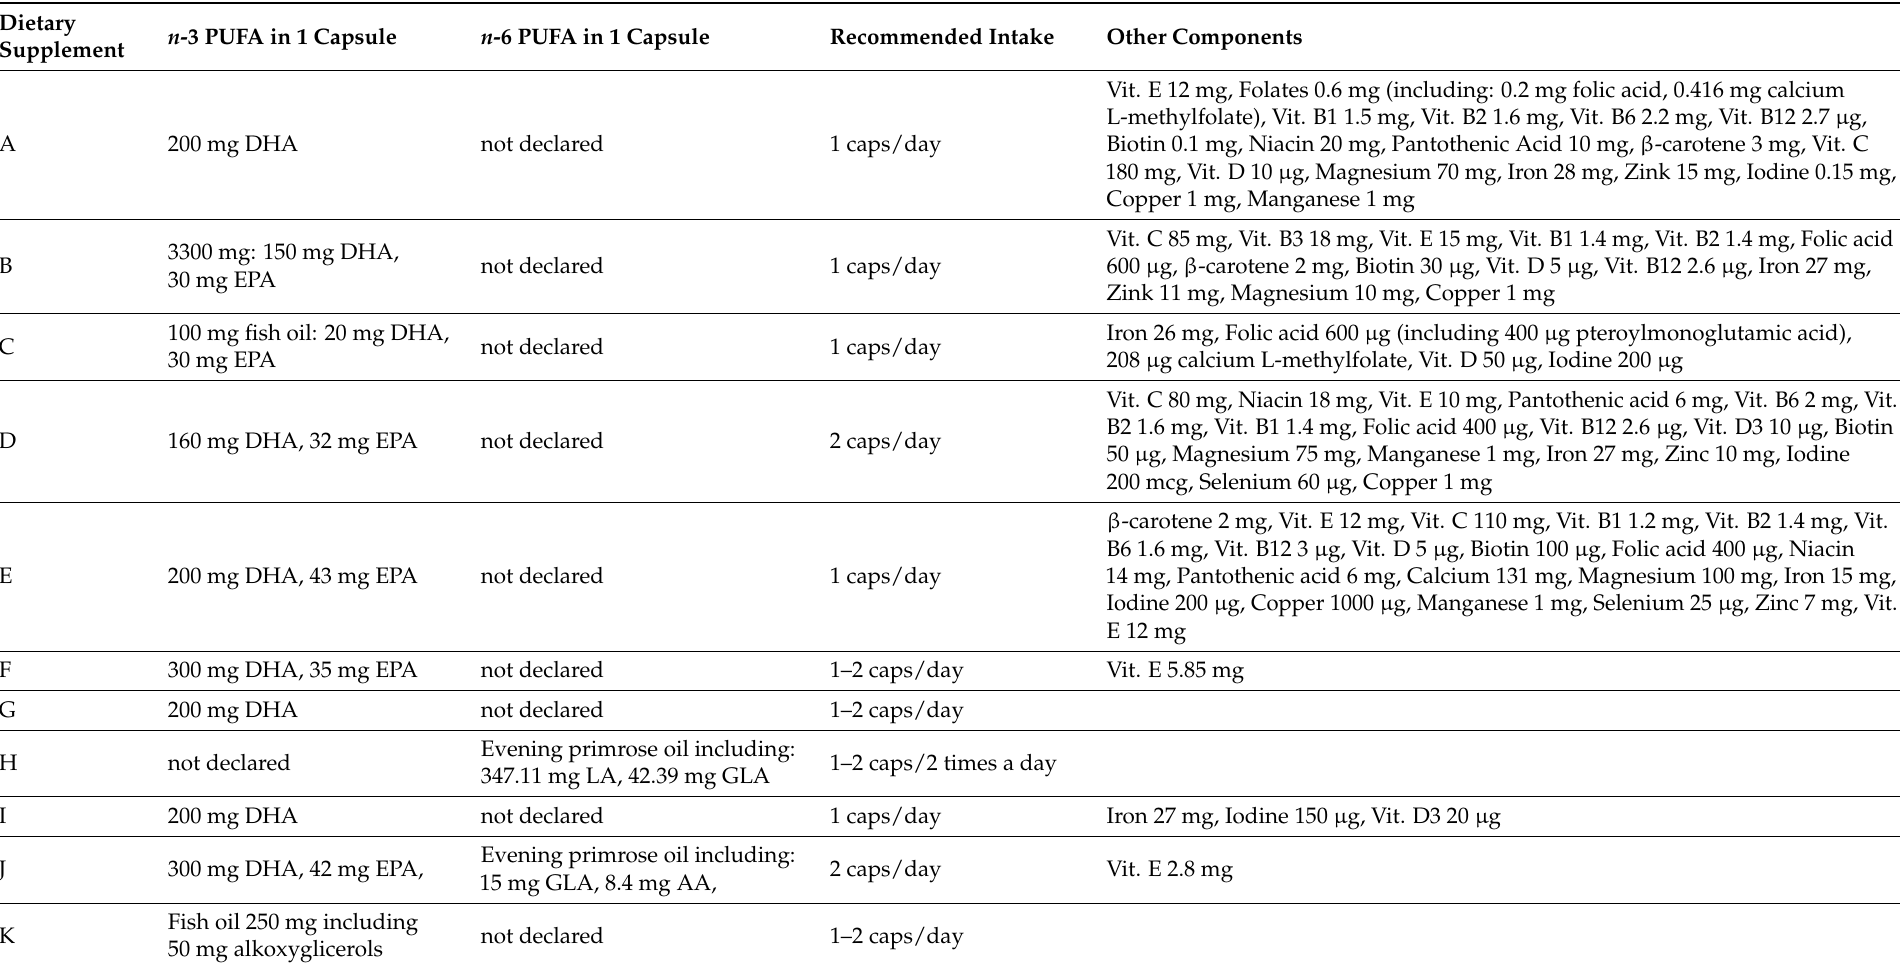
Table 4. Detailed composition of applied omega dietary